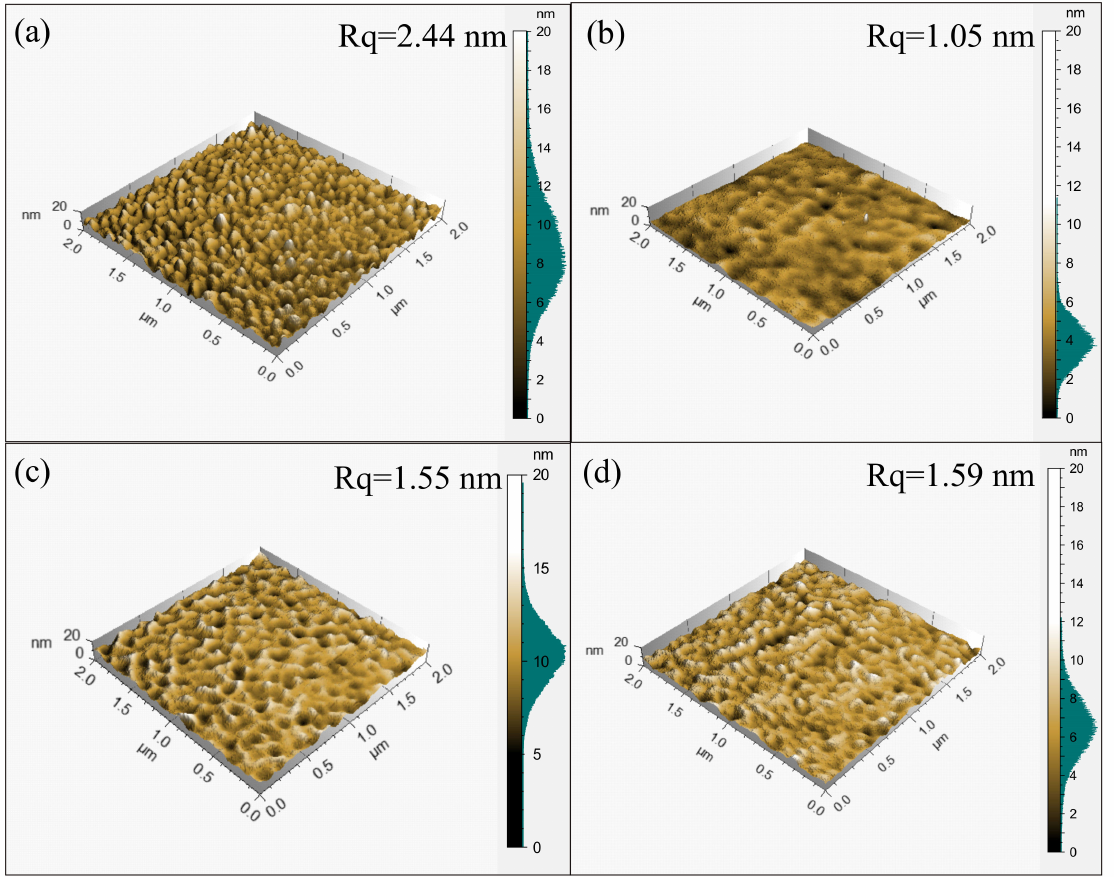
Figure 3. AFM micrographs and the RMS roughness (Rq) of the Ti-DLC coatings prepared at different substrate bias voltages: ( a ) − 50 V, ( b ) − 100 V, ( c ) − 200 V, and ( d ) − 300